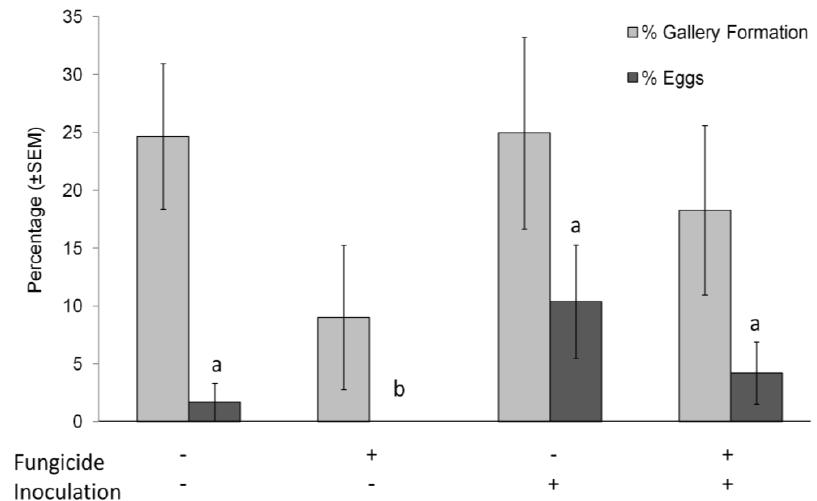
Figure 3. Post-attack successful ambrosia beetle % gallery formation (±SEM) and % of galleries containing eggs (±SEM). Fungicide+ = plants treated with Pageant ® Intrinsic ® ; Inoculation+ = plants inoculated with P. cinnamomi . Bars with different letters are significant at p < 0.05 by Scheffe pair-wise comparison.